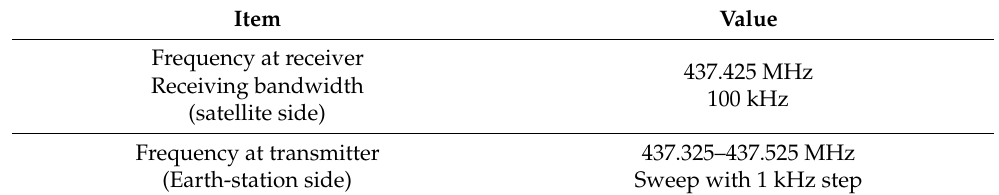
Table 9. Frequency shift tolerance test parameters.